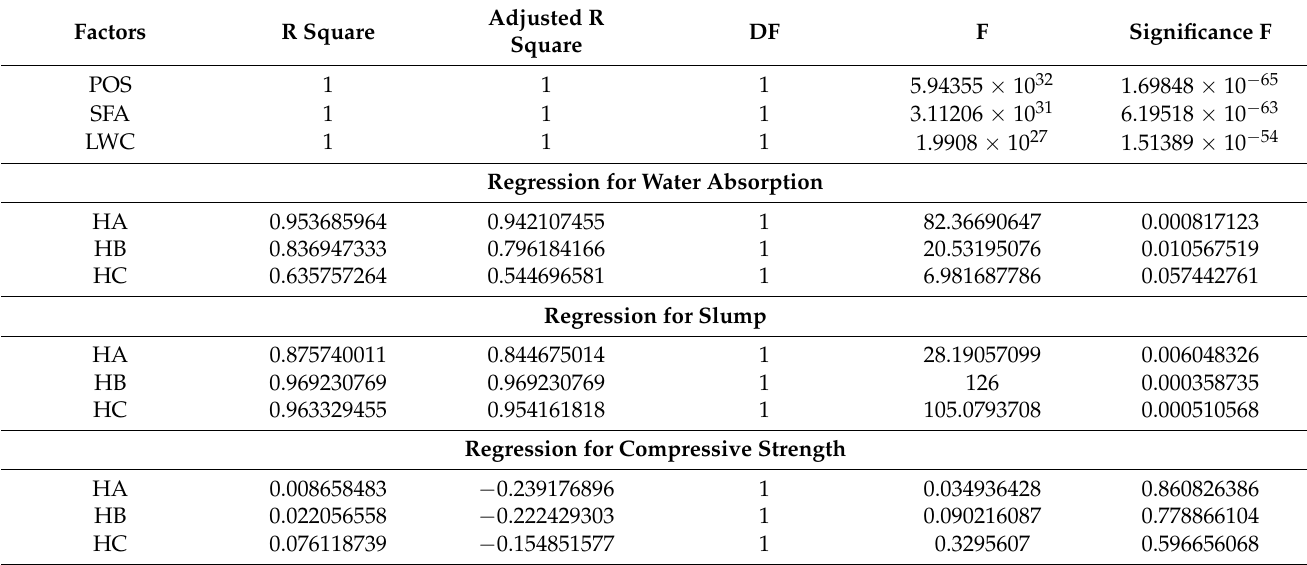
Table 13. Regression for bulk